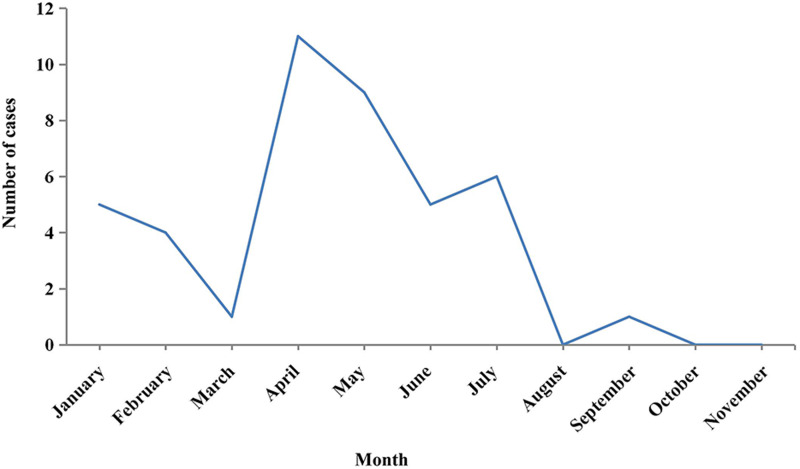
Monthly report of HFRS cases in three regions of Xuancheng from January to November, 2016.